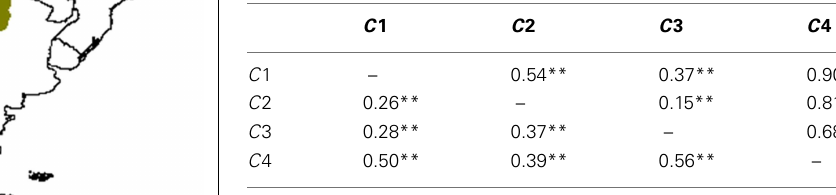
Table 5 | Genetic divergence ( F ST and R ST , below and above the diagonal, respectively) between the four cpSSR clusters identified by population structure